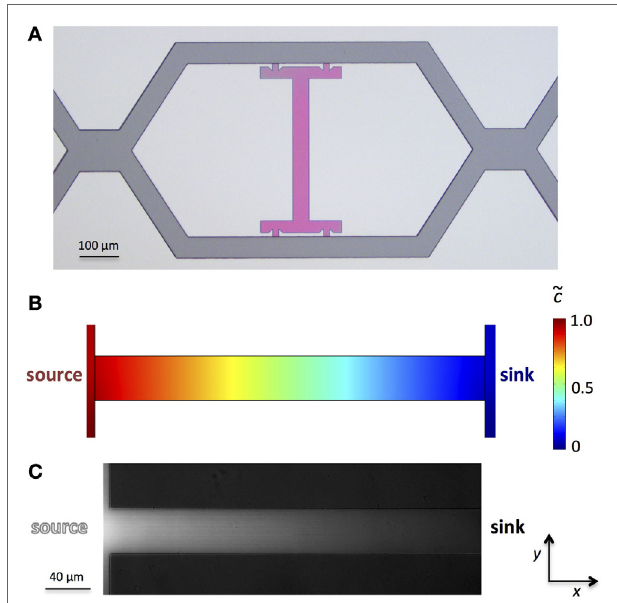
FigUre 2 | experimental realization of a microfluidic device for flow-free and steady-state linear gradients . (a) Bright field micrograph of the device master prepared by photolithography. The multi-height design is evident by the different interference colors of the flow channels (dark gray) and the rectangular microchamber with bypasses (pink). The simulated linear concentration gradient (B) can be verified by an aqueous fluorescein solution using the left flow channel as the fluorescein source and the right as the sink (c)